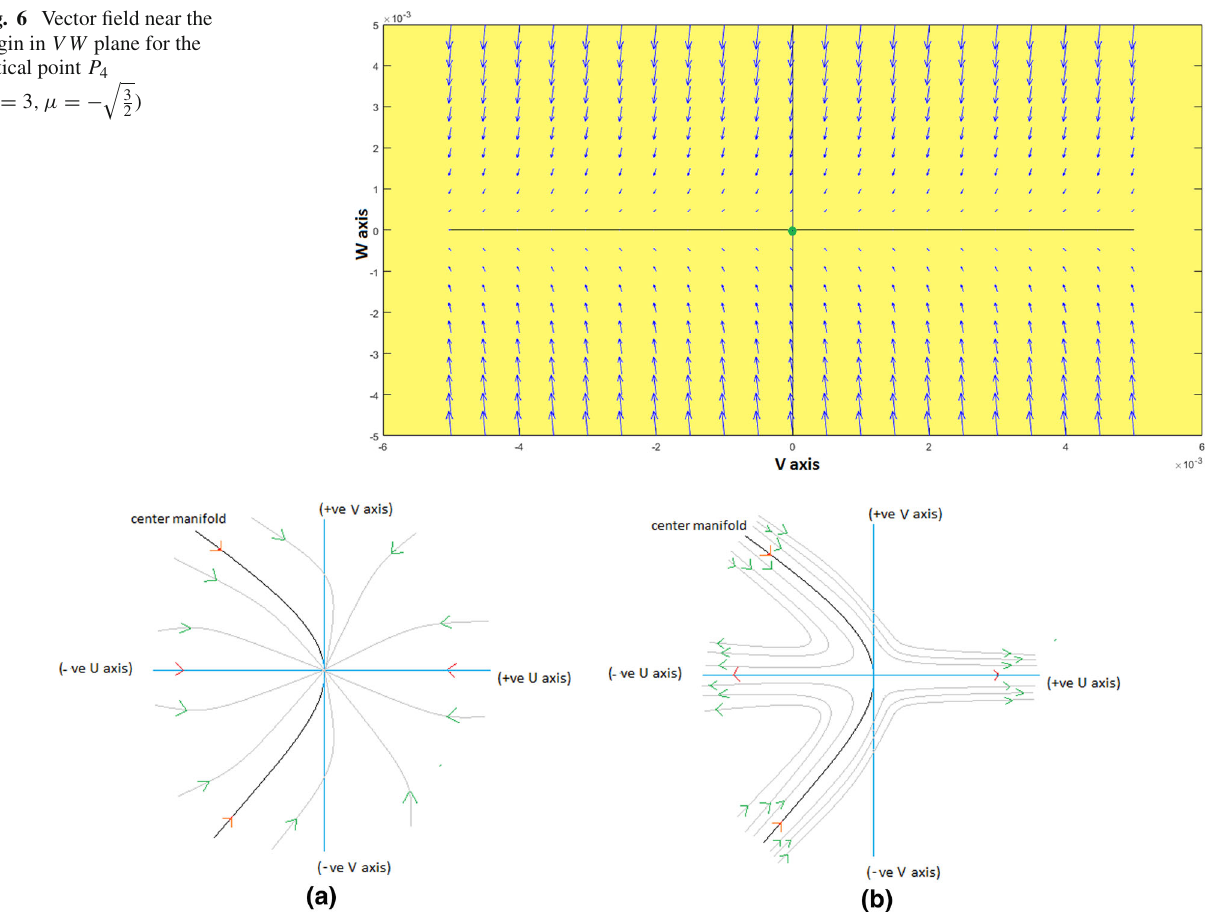
Fig. 6 Vector field near the origin in V W plane for the critical point P 4